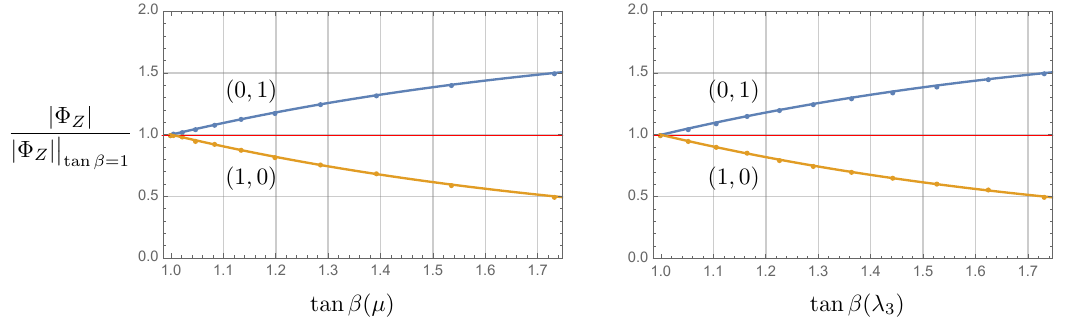
Figure 9 . Ratio of the Z (cid:13)ux obtained data, while curves are drawn by using analytical expressions in eq. (6.8). For numerical computation, we set the parameters g = g 0 = m = (cid:21) 1 = (cid:21) 2 = (cid:21) 4 = 1. For the left panel, we (cid:12)xed (cid:21) 3 (= 0) and varied the value of (cid:22) , while for the right panel, we (cid:12)xed (cid:22) (= 0) and varied the value of (cid:21) 3 . In both panel, ratios are plotted as functions of tan (cid:12) .